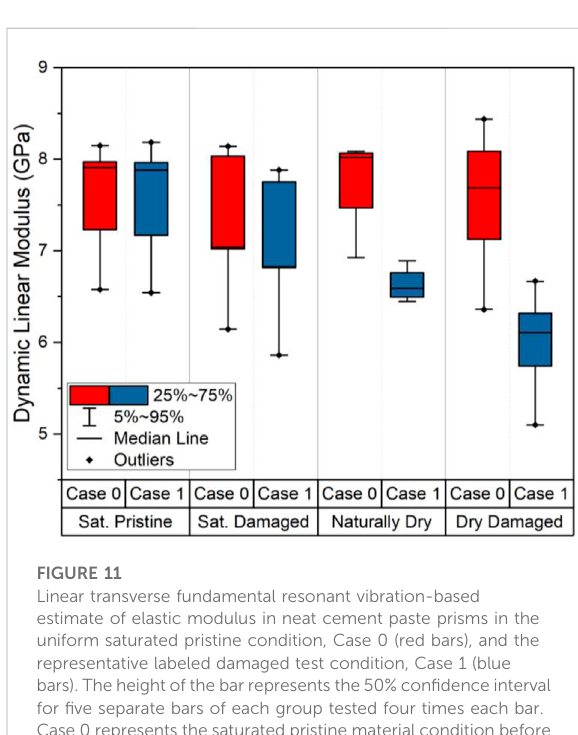
FIGURE 11 Linear transverse fundamental resonant vibration-based estimate of elastic modulus in neat cement paste prisms in the uniform saturated pristine condition, Case 0 (red bars), and the representative labeled damaged test condition, Case 1 (blue bars). The height ofthe barrepresents the50% con fi dence interval for fi ve separate bars of each group tested four times each bar. Case 0 represents the saturated pristine material condition before exposure to the subject